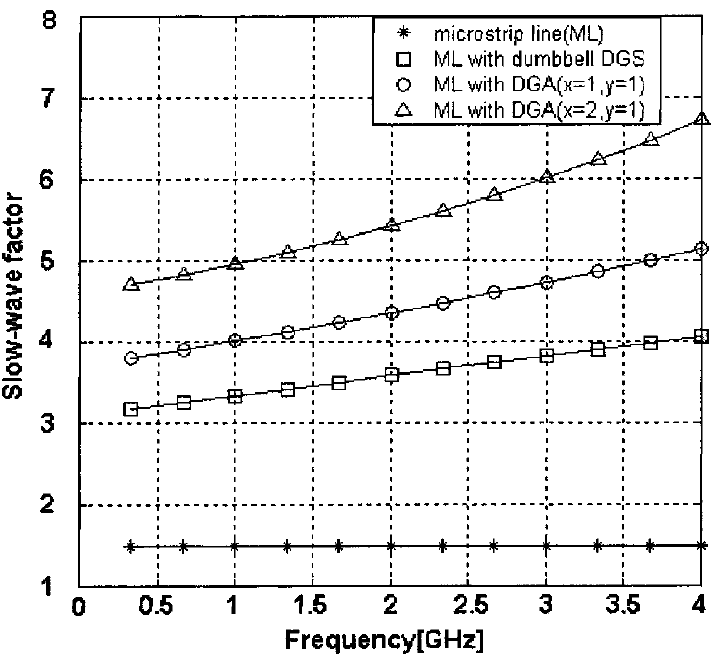
FIGURE 5 Comparison of the slow-wave